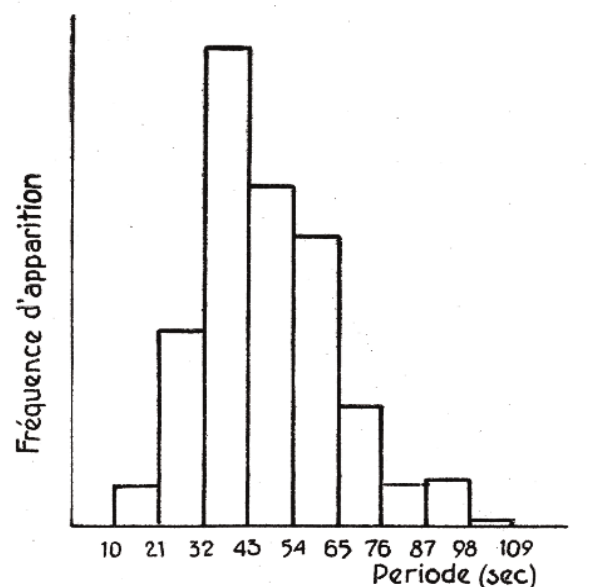
Figure 5. Fréquence d’apparition des pt suivant leur période (d’après Kato et